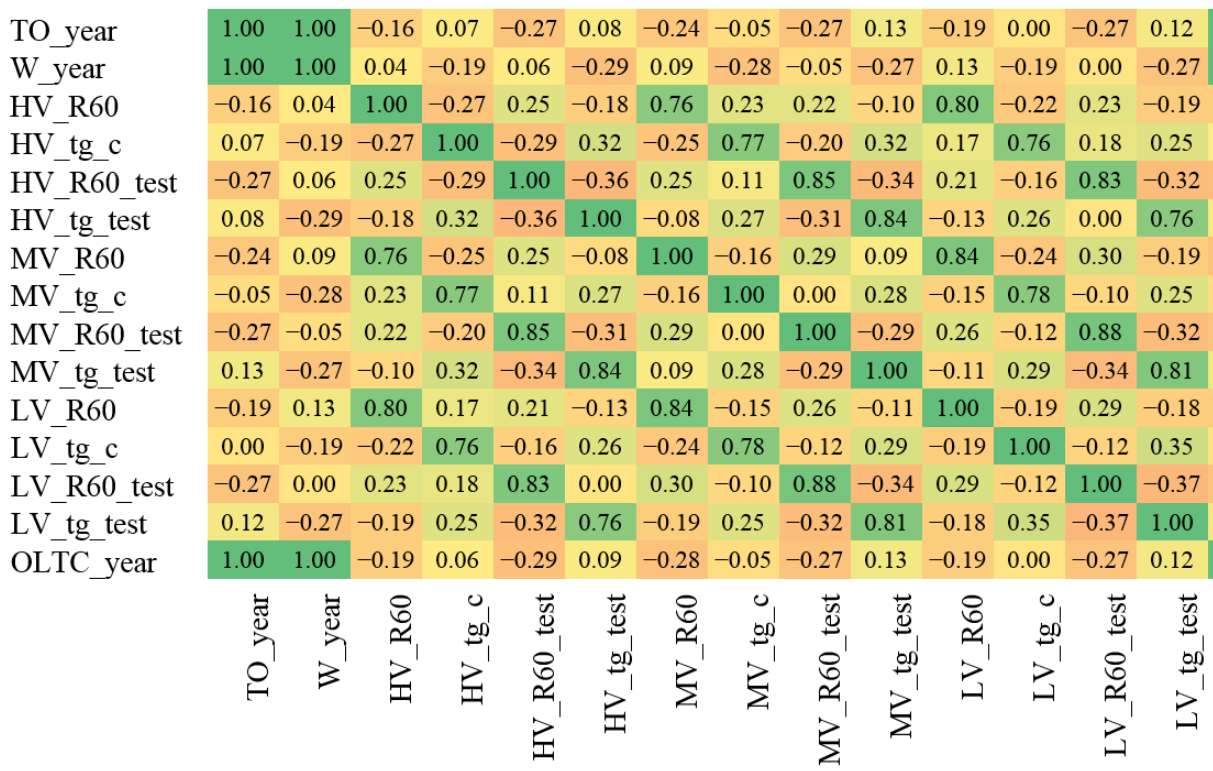
Figure 8. Fragment of Spearman cross-correlation matrix for the features.